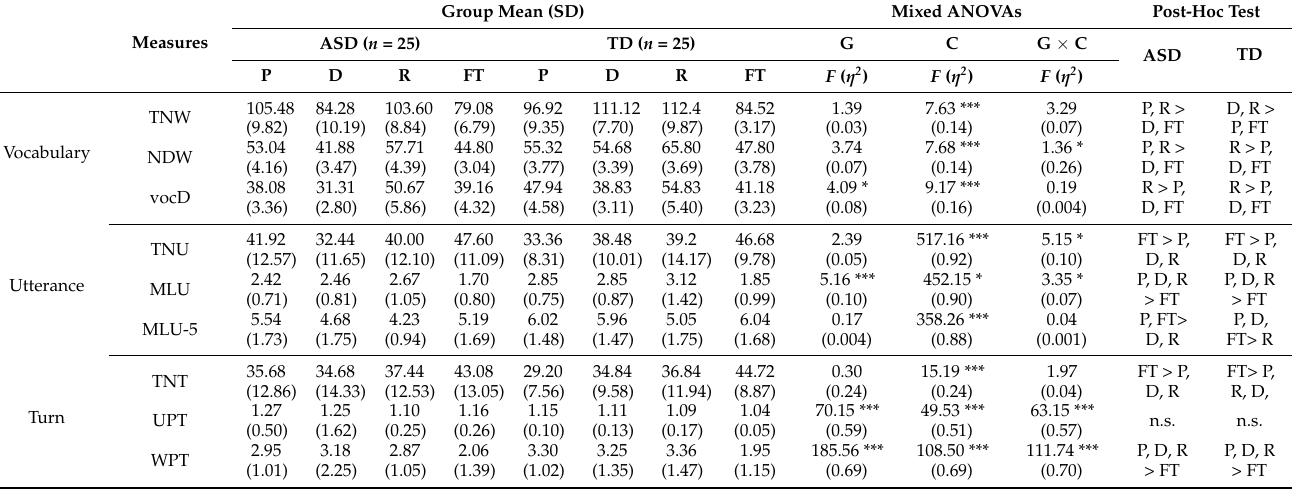
Table 3. Effects of group (ASD/TD) and context (playing/drawing/reading/free talking) on in- teractive language measures (vocabulary/utterance/turn): Descriptive statistics and results of mixed